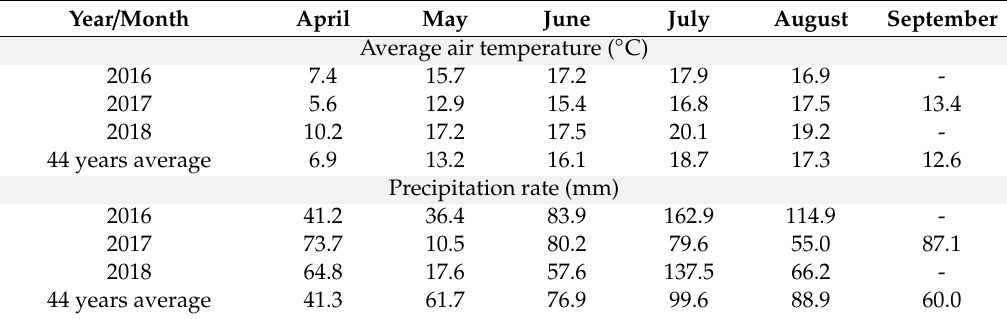
Table 1. Meteorological conditions during the faba bean vegetation (Kaunas Meteorological